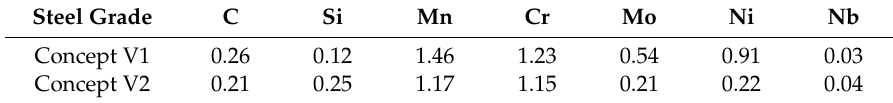
Table 2. Chemical composition of developed case carburizing steels (alloy additions in wt %).